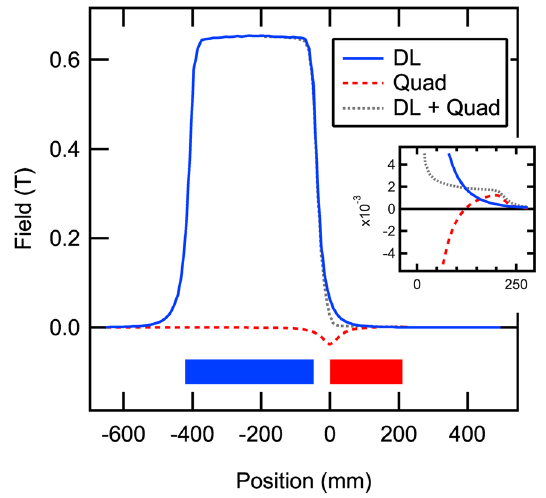
FIG. 4. Simulated longitudinal profile of the vertical field of interacting DL1 high field dipole module (0.67 T) and QD2 moderate gradient quadrupole ( 57 T = m, 94.5 A). The small graph inserted on the right shows the field distribution inside the